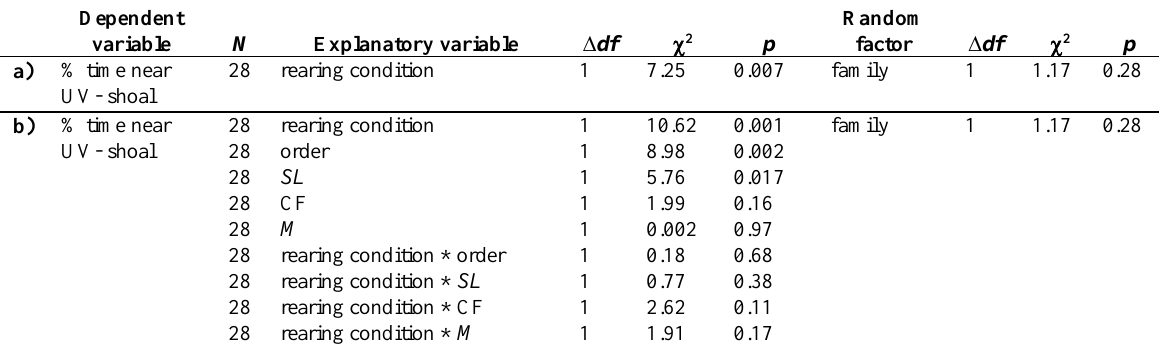
UV Shoal Choice Experiments. Analysis of variables affecting the proportion of time test fish reared either under UV+ or UV- lighting conditions spent near the shoal seen through the UV-blocking (UV-) filter